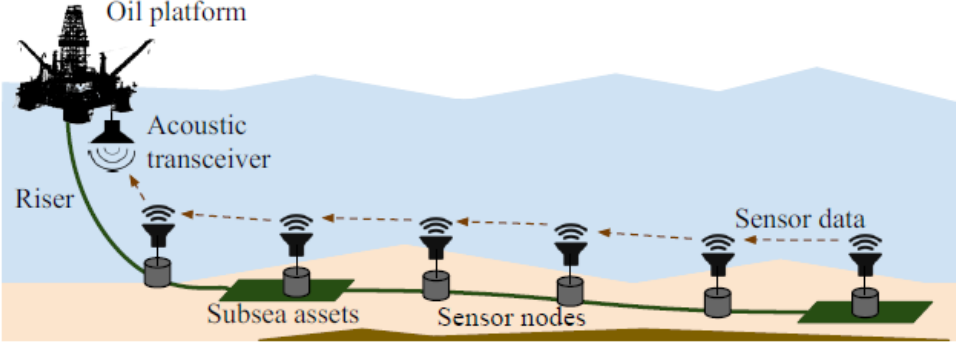
Figure 1. A typical linear UASN subsea asset monitoring scenario (Taken with permission from [11]. Copyright 2019 IEEE Networking